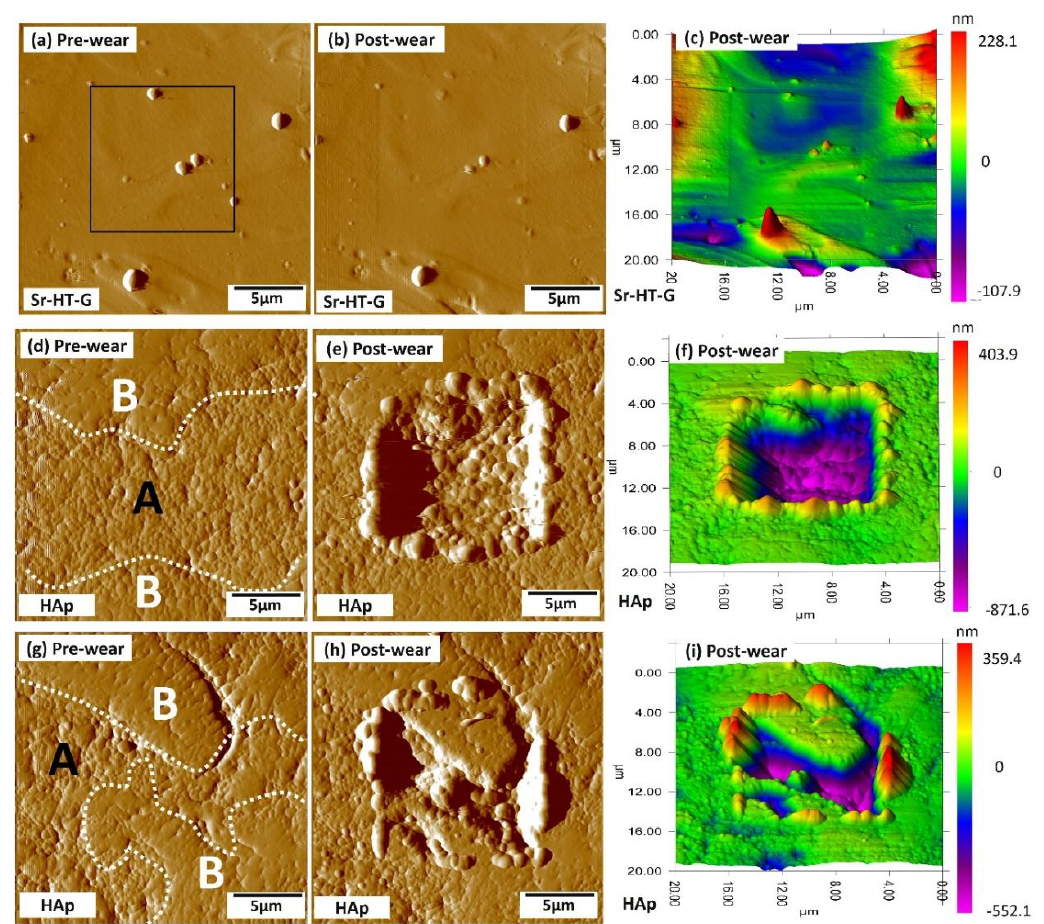
Figure 11. Nanowear test results of the Sr–HT–G coating ( a – c ) and the HAp coating ( d – i ).